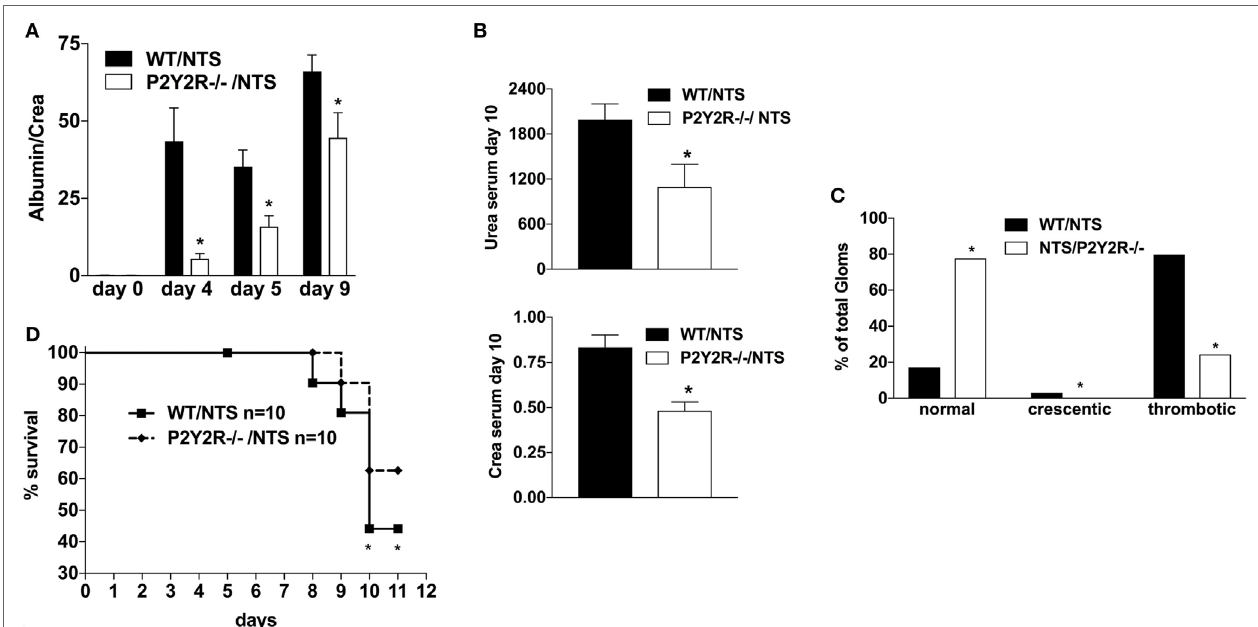
FigUre 5 | Effect of P2Y2-deficiency in mice with nephrotoxic serum (NTS)-driven glomerulonephritis (GN). P2Y2-receptor − / − mice or wild-type animals (all C57BL/6 mice) received NTS (solved in PBS) intravenously on days 1, 2, and 3 to induce GN. Urine was collected on days 4, 5, and 9 and analyzed for its albumin–creatinine quotient (a) . Animals were killed on day 10 after a blood sample had been taken. This was analyzed for its serum urea and creatinine levels (B) . From the killed animals, kidney tissue was prepared and analyzed with microscopy (PAS-staining). Approximately 100 Glomerula in each sample were analyzed following the histological criteria “normal, crescentic, or thrombotic” (c) . We also performed a survival experiment following the same experimental setup (D) . Data are shown as mean ± SEM, n = 5 mice in each group. * P < 0.05. Data from one representative experiment out of two are